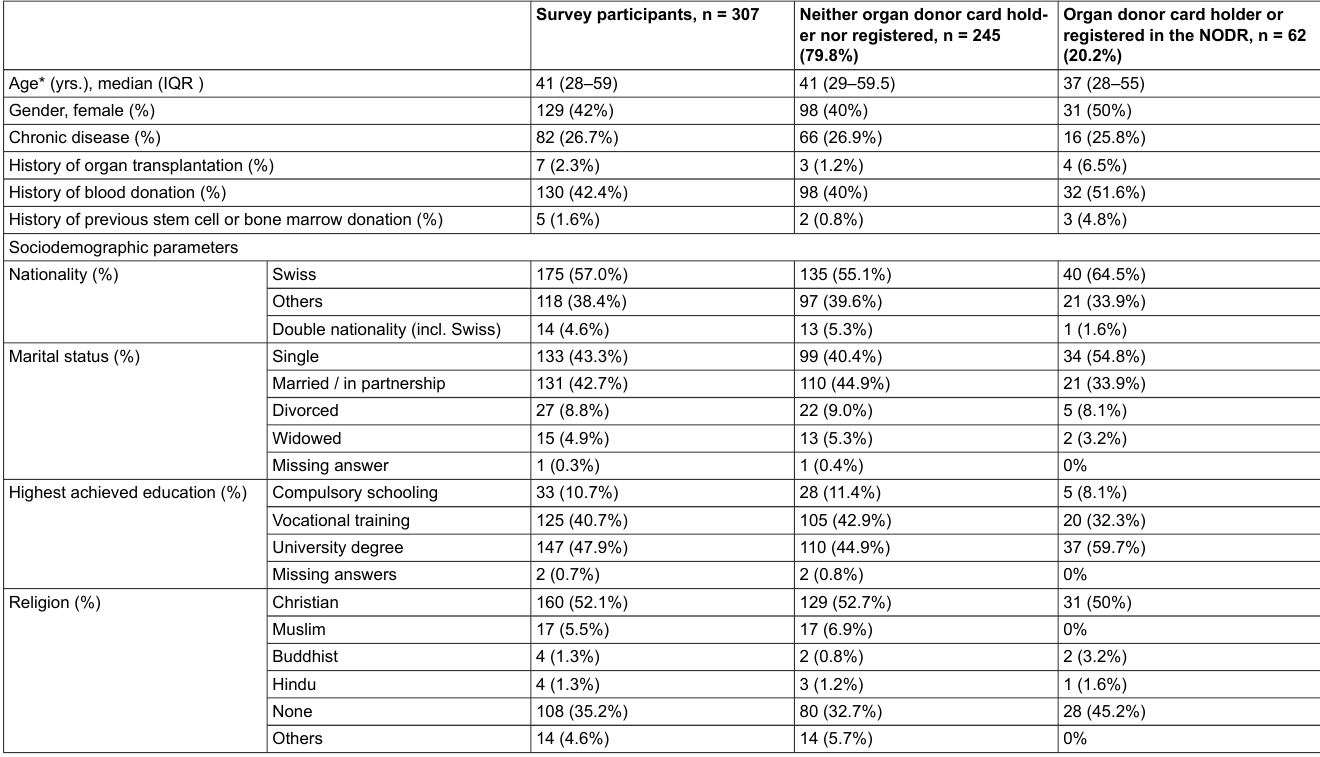
Table 1: Patients’ characteristics.